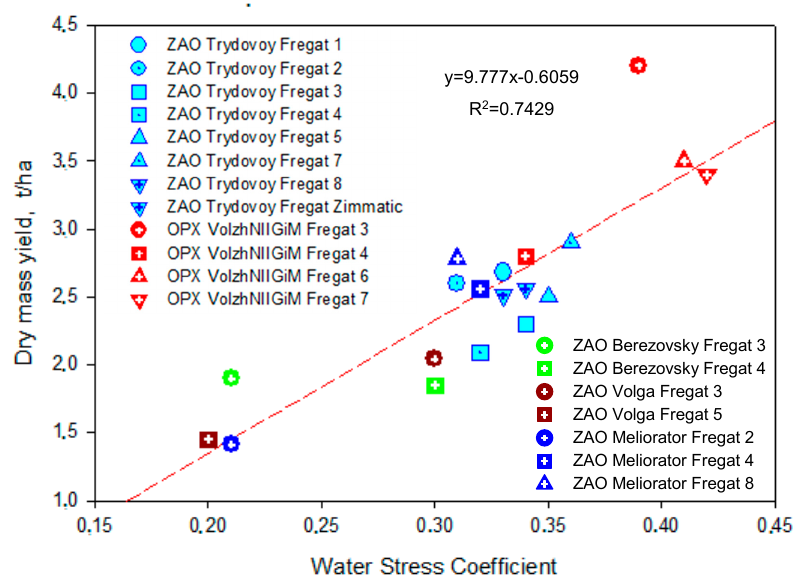
Figure 3. Correlation between values of water stress coefficient and dry mass yield of alfalfa crops. The linear correlation between irrigated agricultural crop productivity and the {K wc } value of IA for the irrigation period revealed the close connection between biomass pro- ductivity and the water stress regime of irrigated alfalfa